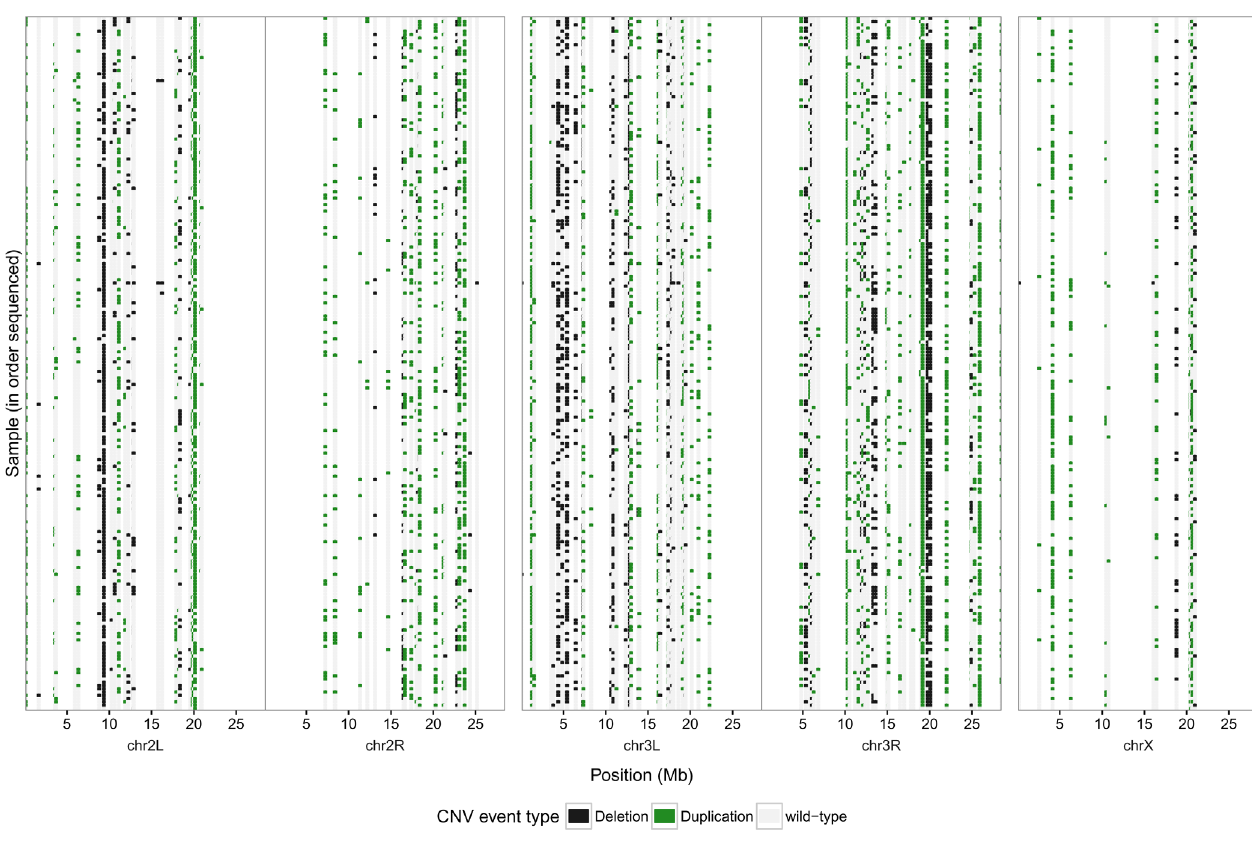
Figure 5. Genomestrip structural variant results across the D. melanogaster genome. Each row corresponds to an individual sequenced (in order originally sequenced from top to bottom, with the reference line at the bottom). Image generated using R/3.3.1 (package ggplot v2.1.0) with data generated by GATK VariantsToTable with individual genotypes as copy-numbers. Data and R code for this figure are located at